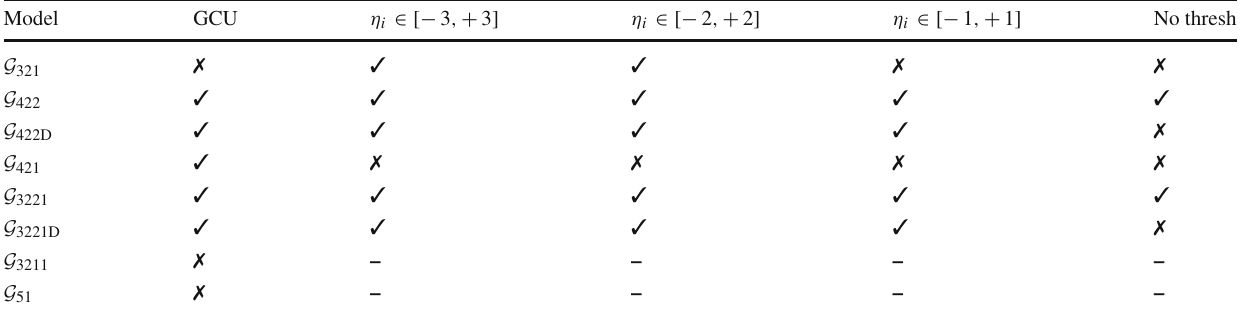
Table1 Comparisonoftheviabilityofthemodelsconsidered.Thesec- ondcolumn(“GCU”)denoteswhetherornotgaugecouplingunification is achieved without threshold corrections. The next four columns show if the predicted proton lifetime is above the lower bound for various sizes of threshold corrections. A checkmark (“ ✓ ”) denotes an allowed